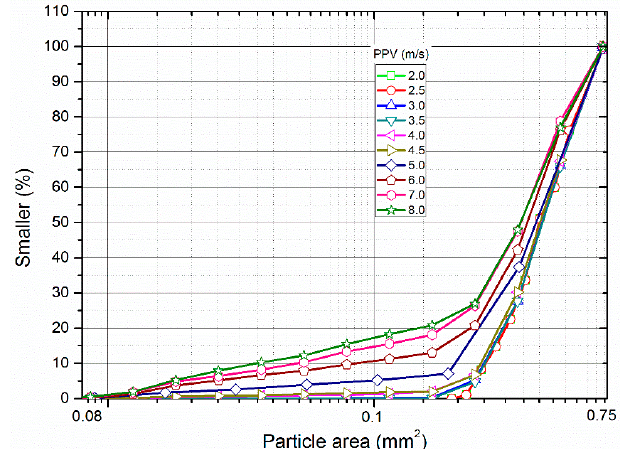
Figure 9. The particle area distribution of the filled particles after loading by stress waves with different PPVs.